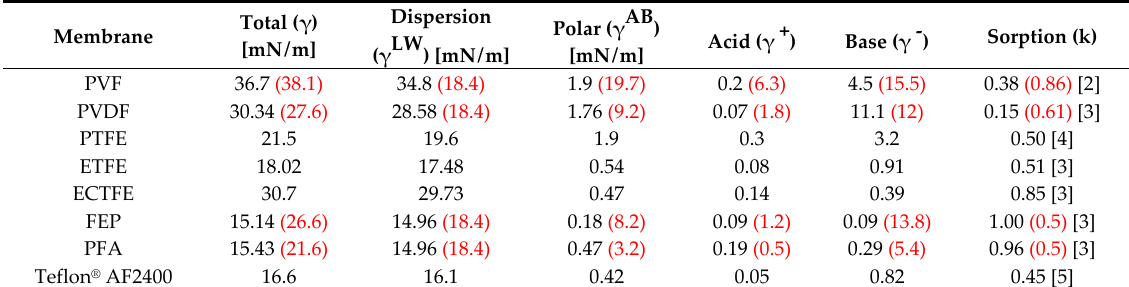
Table 2. Surface energies and other parameters of the fluoropolymers. The sorption coefficient k S was calculated using literature data. The measured values are highlighted in